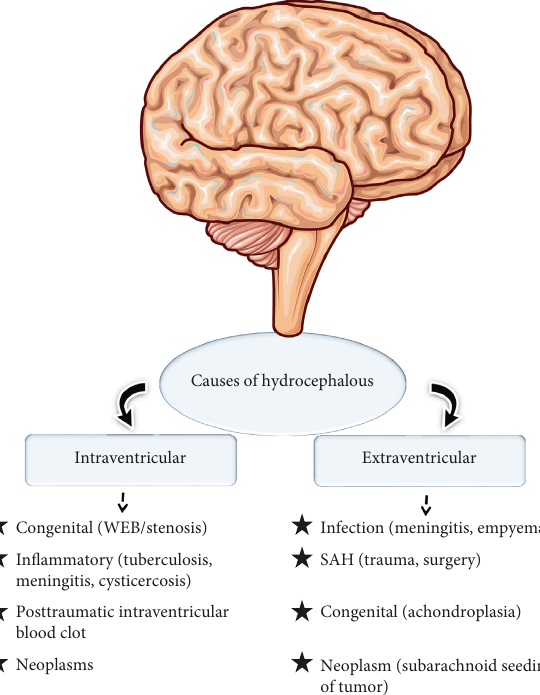
Figure 4: Causes of hydrocephalus. Examples of hydrocephalus caused in extraventricular and intraventricular are